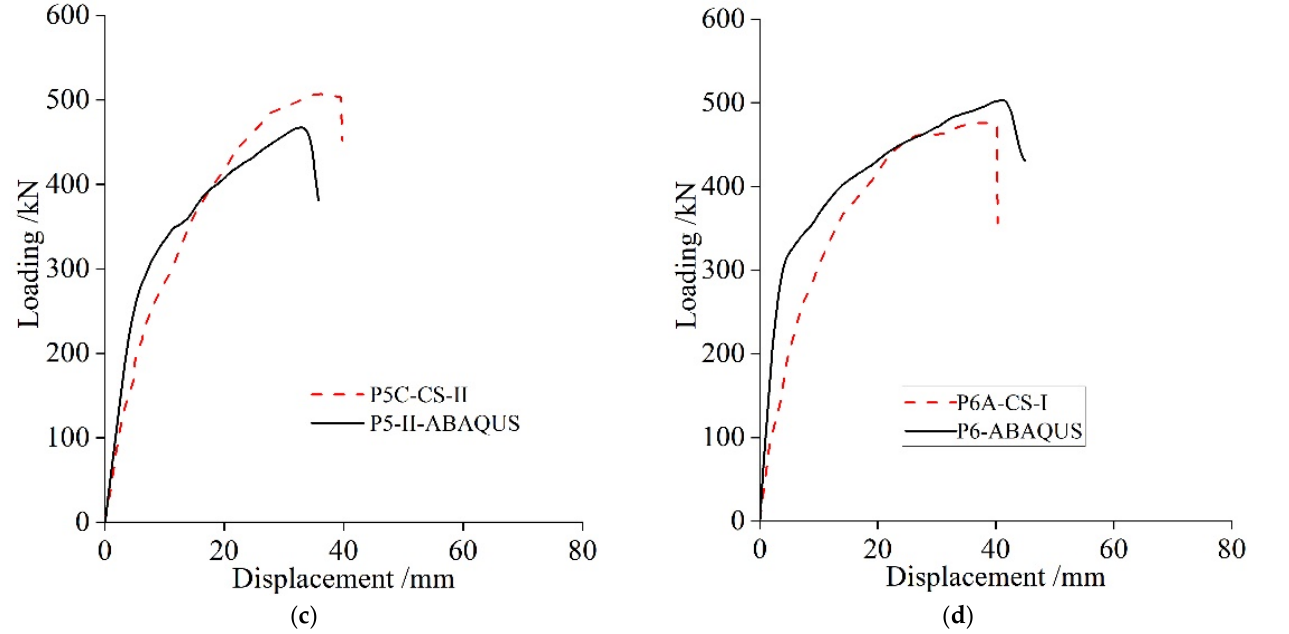
Figure 14. Comparison of load–displacement curves between FEA and experimental results: ( a ) P4B-CS-I, ( b ) P5B-CS-I, ( c ) P5C-CS-II, ( d ) P6A-CS-I.